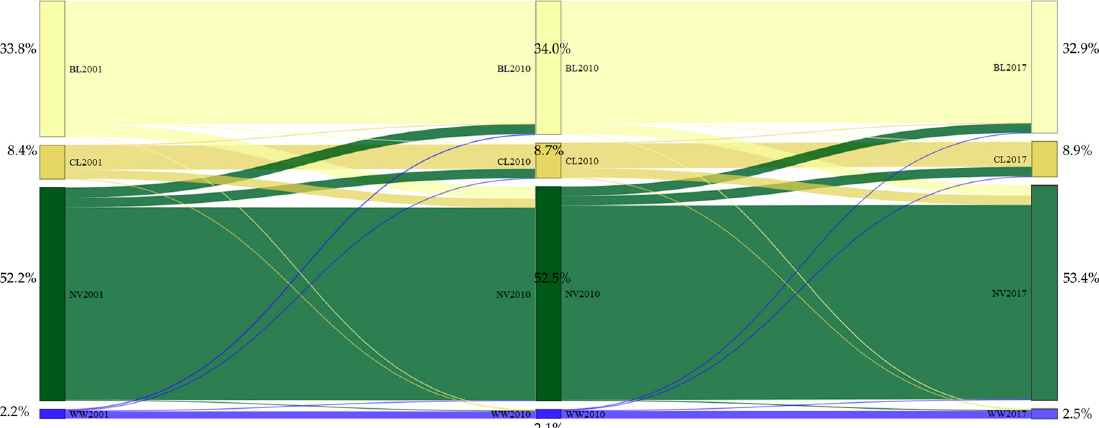
Figure 8. Sankey plot showing changes from one land use land cover class to another between 2001, 2010 and 2017. The numbers beside boxes indicate the percentage of the area of the land cover type based on the total study area. BL: Bareland, CL: Cropland, NV: Natural vegetable, WW: Water bodies&Wetland.